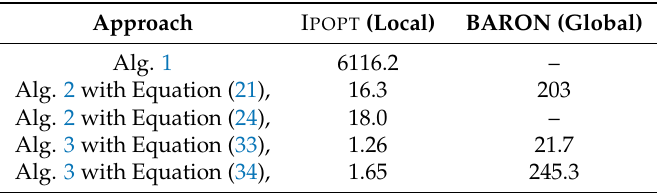
Table 2. Timing results for Case Study 2 (in